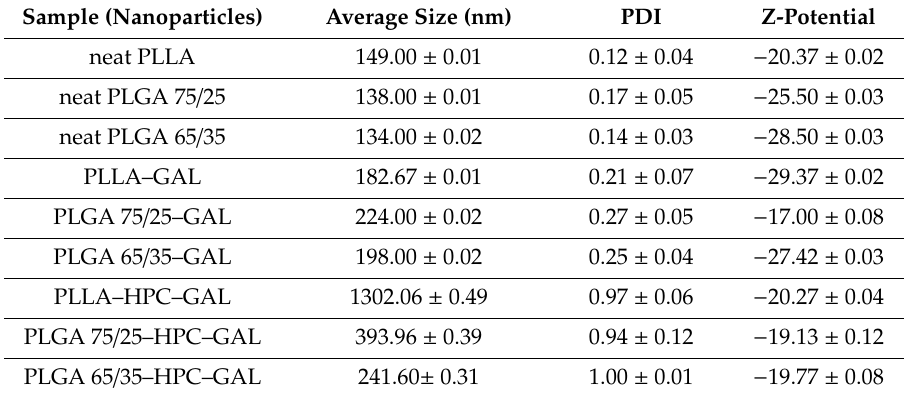
Table 2. Average size and ζ -potential for various nanoparticle systems that were obtained by dynamic light scattering (DLS).